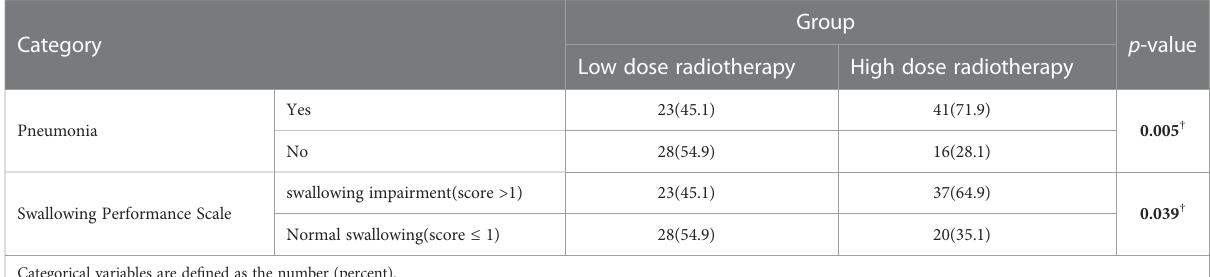
TABLE 3 Differences in the prevalence of pneumonia and swallowing scores between the two groups.